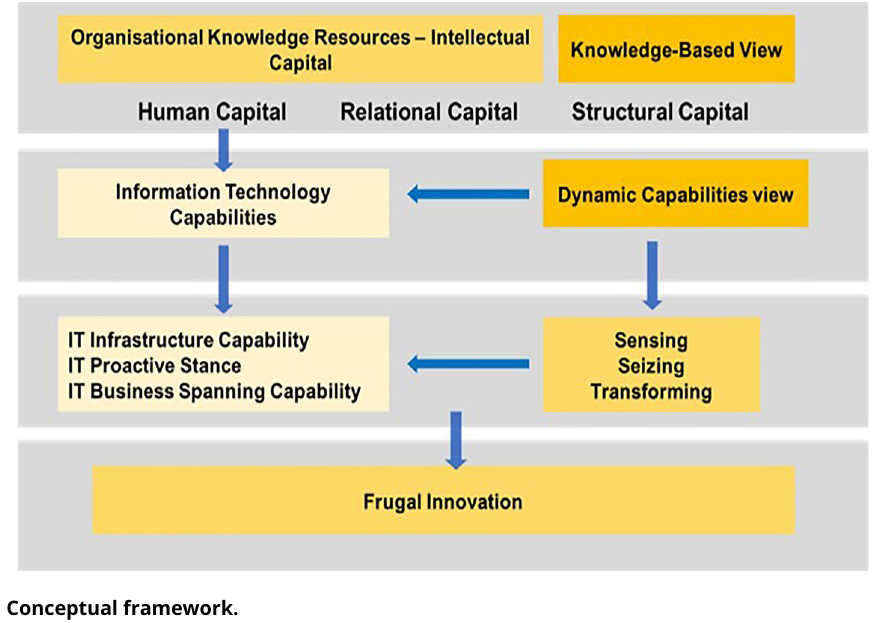
Figure 8. Conceptual framework.